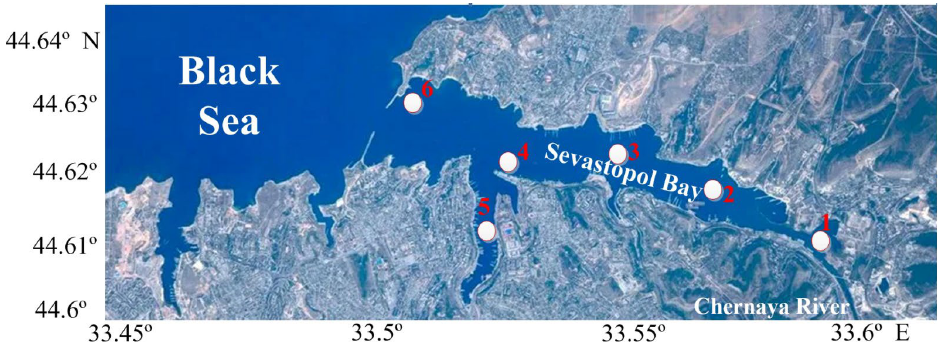
Figure 1. Map showing the study area of ichthyoplankton sampling stations in Sevastopol Bay: 1, Inkerman; 2, Sukharnaya bay; 3, Avlita; 4, Pavlovsky Cape; 5, South Bay; 6, Ravelin.